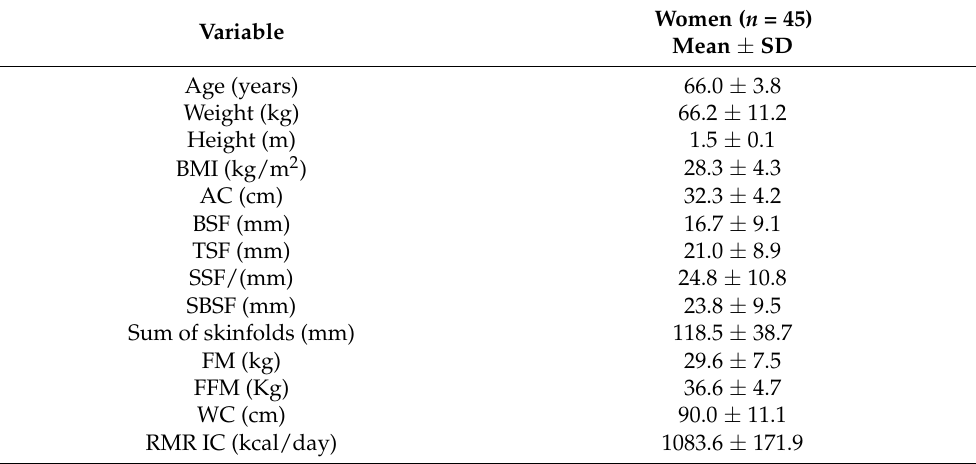
Table 1. Age, anthropometry, body composition, and resting metabolic rate of the participants measured by indirect